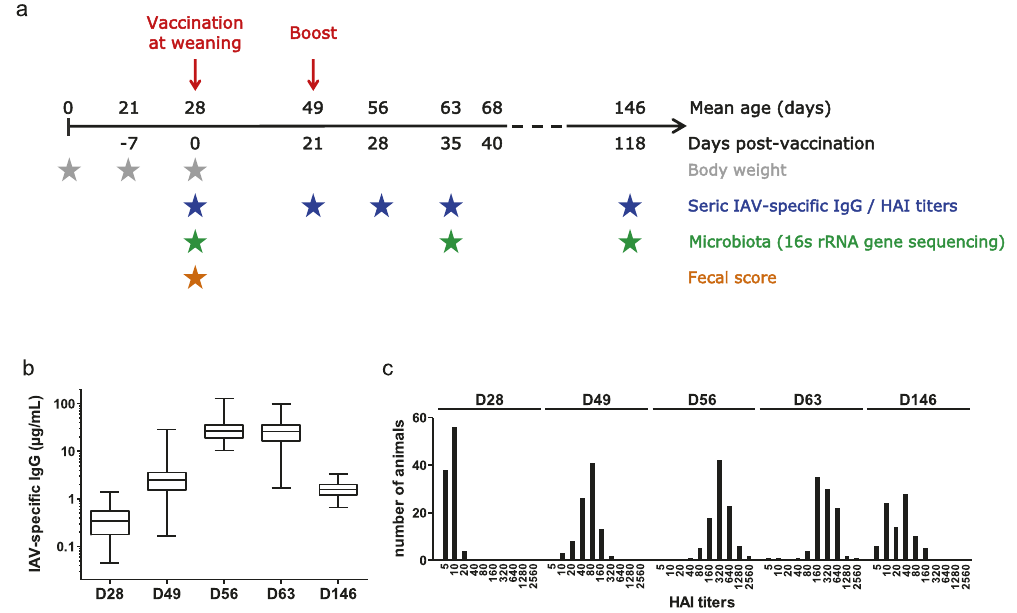
Fig. 1 Experimental design and timeline of the Ab response after vaccination against IAV. a Summary of the protocol design, animal sampling, and data production. The timeline represents the mean age of the animals both from birth (above the line) and from the vaccine day (below the line). Animal parameters included body weight (gray stars) and fecal score at weaning on the vaccine day (red star). Stool samples were collected at three time points for 16S rRNA sequencing (green stars). In order to follow the vaccine response dynamics over time, blood was collected at fi ve time points from the vaccine day until slaughtering (blue stars) for further seric dosage of IAV-speci fi c IgG and measurement of HAI titers. b Box plot representation of IAV-speci fi c IgG seric levels from vaccinated animals at D28 (before vaccination), D49, D56, D63, and D146. Box plots show minimum values, maximum values, median, and interquartile ranges. c Distribution of HAI titers measured from sera of vaccinated animals at D28 (before vaccination), D49, D56, D63, and